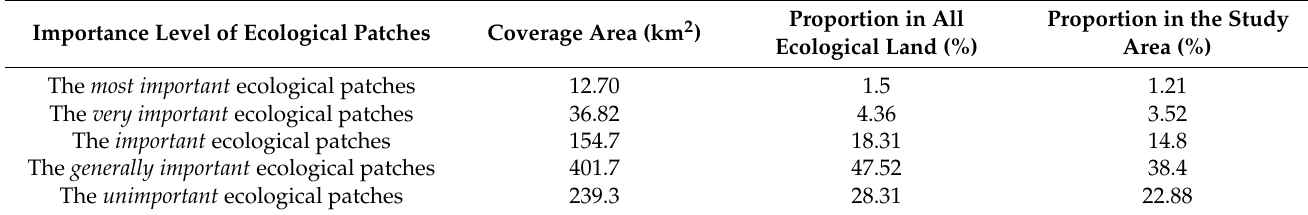
Table 2. Area and proportion of ecological land at different importance